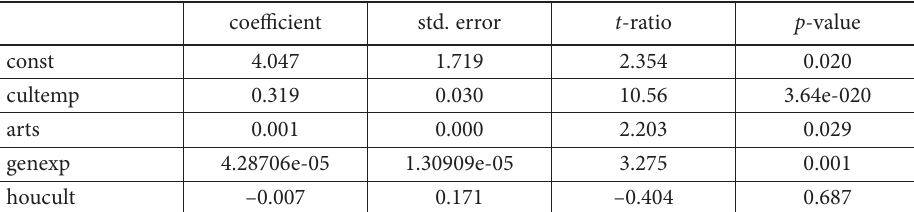
Table 7. 2011–2017 panel regression analysis (source: compiled by the author)